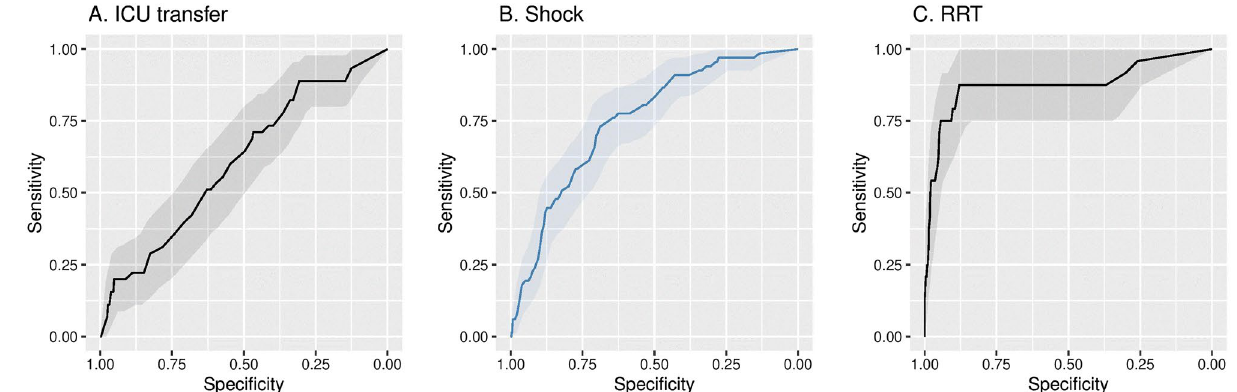
Figure 5. Receiver operator characteristics curves for ICU transfer, shock, RRT. ( A ) Receiver operator characteristics for ICU transfer in the cross-validation cohort. ( B ) Receiver operator characteristics for shock in the cross-validation cohort. ( C ) Receiver operator characteristics for RRT in the cross-validation cohort.